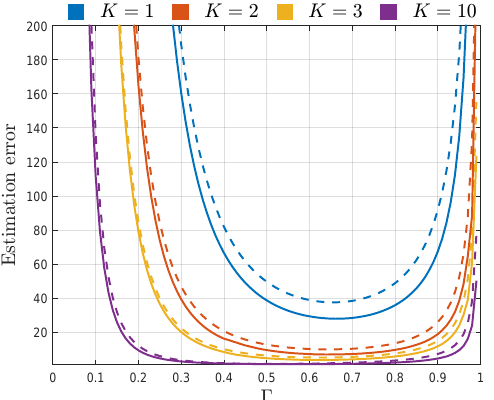
(cid:112) CRB K N / K 2 (solid line) and Figure 4. values of Γ .